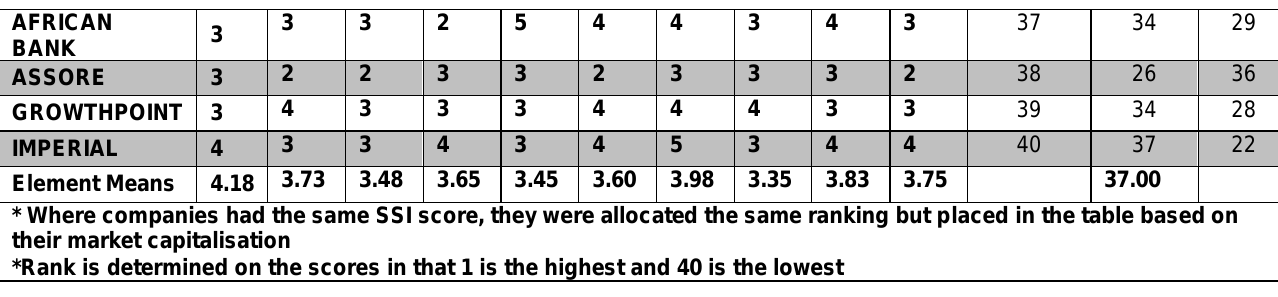
Figure 1: Comparative depiction of the SSI element scores for three sample companies compared with the overall mean scores per element